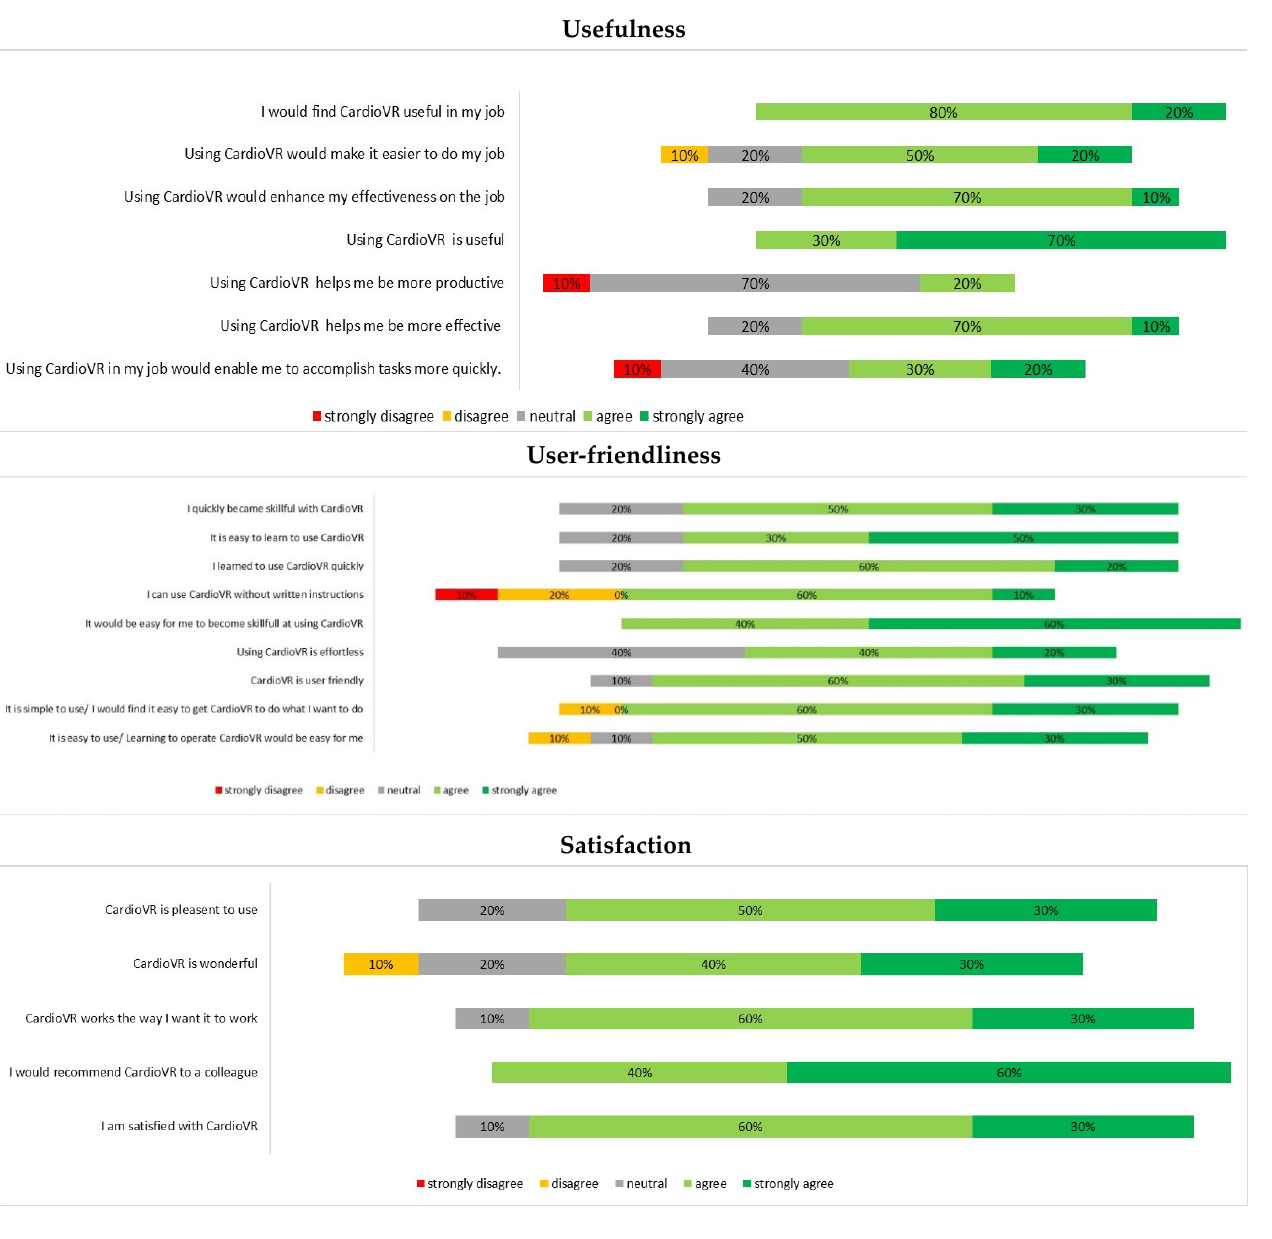
Figure 4. Questionnaire results on the virtual reality experience of participating surgeons for the preoperative planning of ascending aortic surgery. preoperative planning of ascending aortic